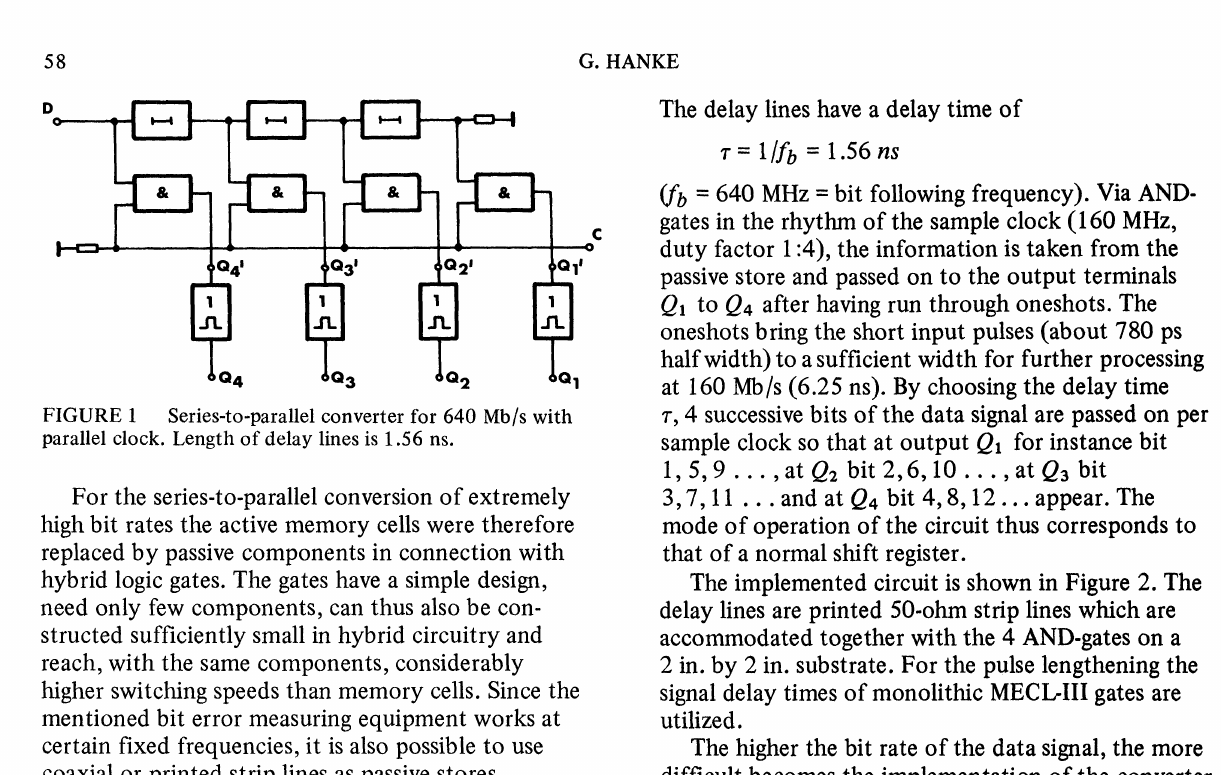
Series-to-parallel converter for 640 Mb/s with parallel clock. Length of delay lines is 1.56 ns.